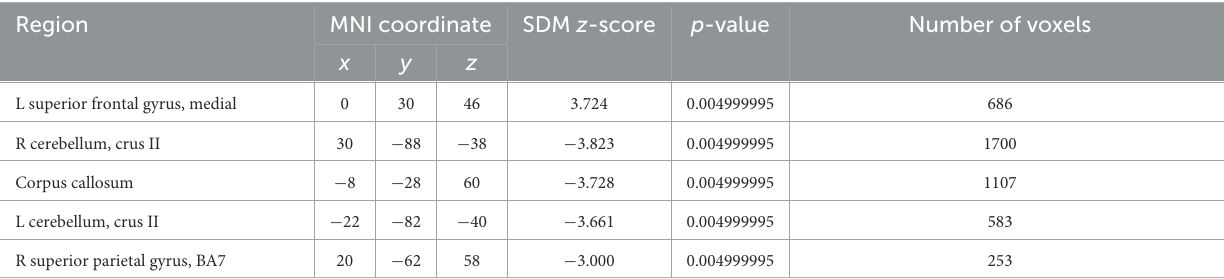
TABLE 8 Meta-regression analysis of SAS in treatment group.